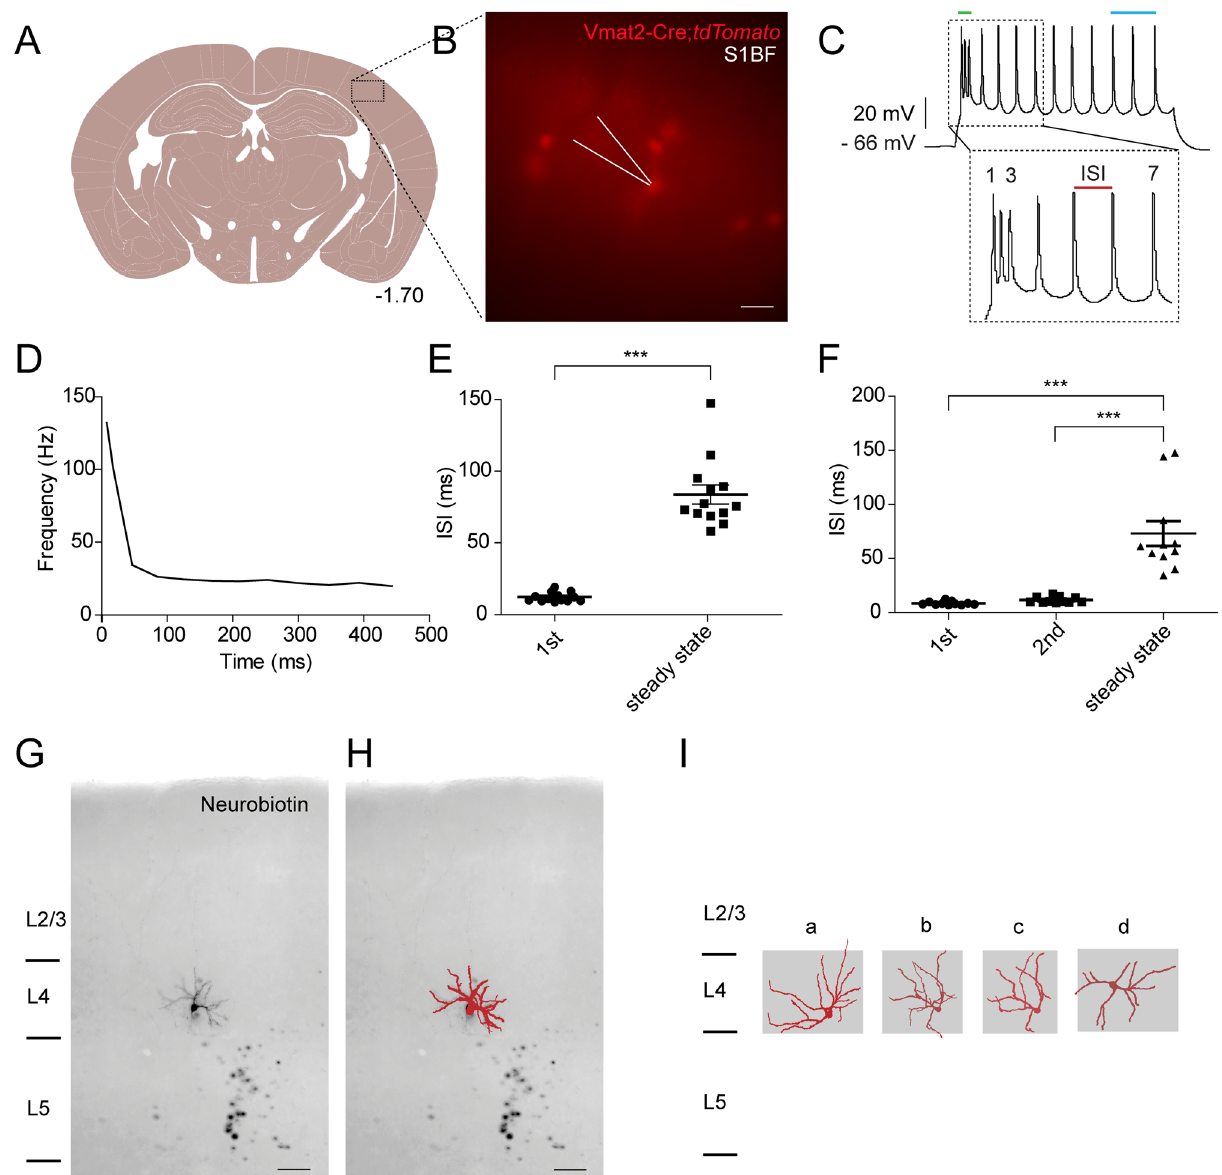
Figure 2. Morphology and electrophysiological properties of the Vmat2-Cre; tdTomato cells. ( A ) Whole cell patch clamp recordings were performed in coronal slices preserving the barrel field cortex. The anatomical figure is adopted from Paxinos and Franklin’s mouse brain atlas 38 . ( B ) Vmat2-Cre; tdTomato expressing cells in somatosensory cortical layer IV. The white arrowhead represents the pipette for patch-clamp recording. Scale bar 25 µm. The image was generated using Image J (Image J 1.51 k), https ://image j.nih.gov/ij/. ( C ) A representative trace of the induced action potential, which demonstrated an initial bursting property. The initial bursting phase is marked with a green line and the steady state phase (the last three spikes) is marked with a blue line. I-S-I is the time interval between two spikes. The image was generated using WinWCP, Version 5.5.5, http://spide r.scien ce.strat h.ac.uk/sipbs /softw are_ses.htm. ( D ) Frequency plot of the recorded action potential in ( B ). ( E , F ) Comparison of I-S-I of recorded action potentials (***p < 0.0001, one-way ANOVA with Bonferroni’s post hoc test) between initial bursting phase and the steady state phase. The initial bursting phases of all the recorded action potentials (n = 24) consist of either two spikes ( E , n = 13) or three spikes ( F , n = 11). Images ( D–F ) were generated using GraphPad Prism version 5.0.1 for Windows, GraphPad Software, San Diego, California USA, www.graph pad.com. ( G ) A Neurobiotin-stained cell (10 × magnification). Cortical layers are marked on the left. The figure is shown in inverted gray scale for a better visualization. ( H ) The overlay of reconstructed dendrites (red) from the Vmat2-Cre neuron in ( G ). Scale bar 40 µm. ( I ) Representative examples of reconstructed Neurobiotin-stained Vmat2-Cre; tdTomato cells showing either asymmetrical (a, b and c) or symmetrical (d) dendritic trees. The scale bar in ( F ) also applies to ( I ). Images ( G–I ) were generated using Simple Neurite Tracer (https ://image j.net/SNT) 54,55 in Fiji, https ://image j.net/Welco